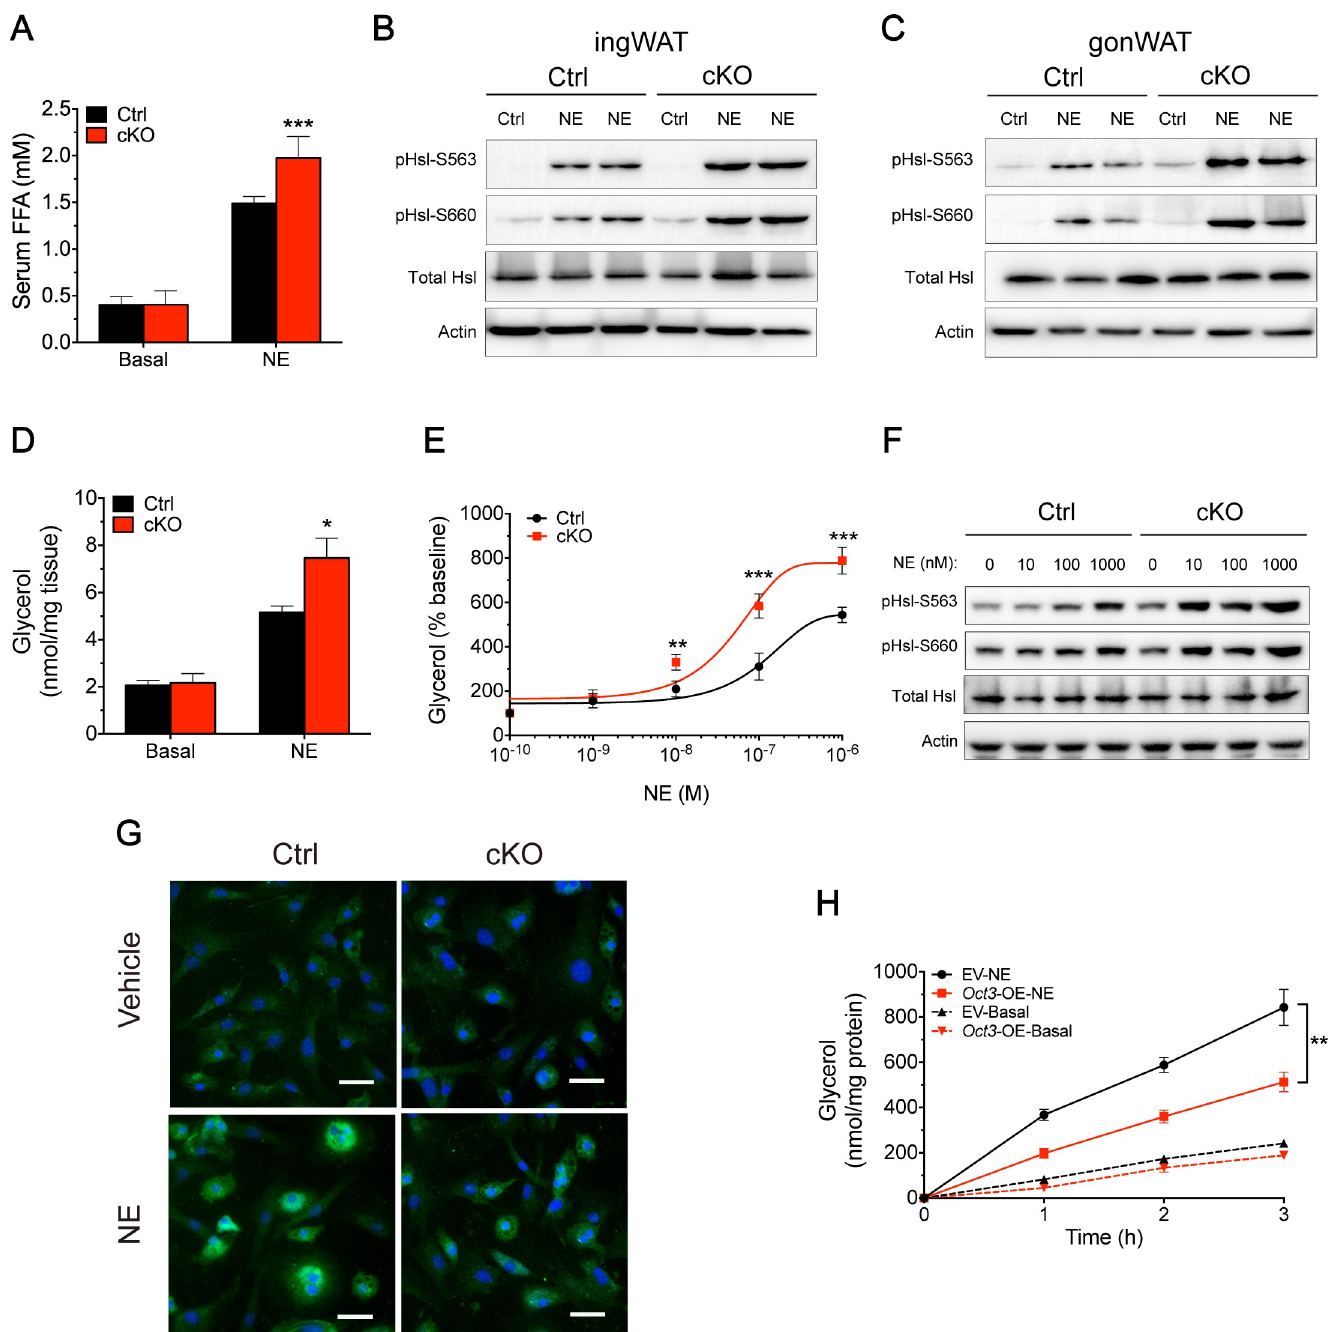
Fig 3. Genetic ablation of Oct3 augmented NE-stimulated lipolysis in WAT. (A) Basal and NE-stimulated lipolysis by measuring serum FFAs in Ctrl and cKO mice ( n = 6). (B, C) Protein levels of Hsl phosphorylated at Ser563 and Ser660 (pHsl-S563 and pHsl-S660, respectively) and total Hsl in ingWAT (panel B) and gonWAT (panel C) of Ctrl and cKO mice with NE (“NE”) or without NE injection (“Ctrl”). (D) Ex vivo glycerol release from AT explants in the absence (“basal”) or presence of NE (“NE”) ( n = 4). (E) In vitro glycerol release from differentiated SVF-derived adipocytes from Ctrl and cKO mice in the absence or presence of NE ( n = 4). (F) Protein levels of pHsl-S563, pHsl-S660, and total Hsl in differentiated SVF-derived adipocytes from Ctrl and cKO mice in the absence or presence of NE. (G) Immunofluorescence analysis of intracellular NE (green) in differentiated SVF-derived adipocytes from Ctrl and cKO mice. Adipocytes were either untreated or treated with NE (100 nM) for 10 minutes. DAPI (blue), nucleus. Scale bar, 50 μ m. (H) Basal and NE-stimulated lipolysis, as measured by glycerol release from differentiated 3T3-L1 adipocytes stably transfected with EVs or Oct3 ( Oct3- OE) ( n = 3). Data in panels A, D, E, and H were analyzed by Student t test. The numerical data underlying this figure are included in S1 Data. cKO, conditional knockout; Ctrl, control; EV, empty vector; FFA, free fatty acid; gonWAT, gonadal white adipose tissue; Hsl, hormone-sensitive lipase; ingWAT, inguinal white adipose tissue; KO, knockout; NE, norepinephrine; Oct3, organic cation transporter 3; OE, over- expression; pHsl, phosphorylated hormone-sensitive lipase; SVF, stromal vascular fraction; WAT, white adipose tissue.